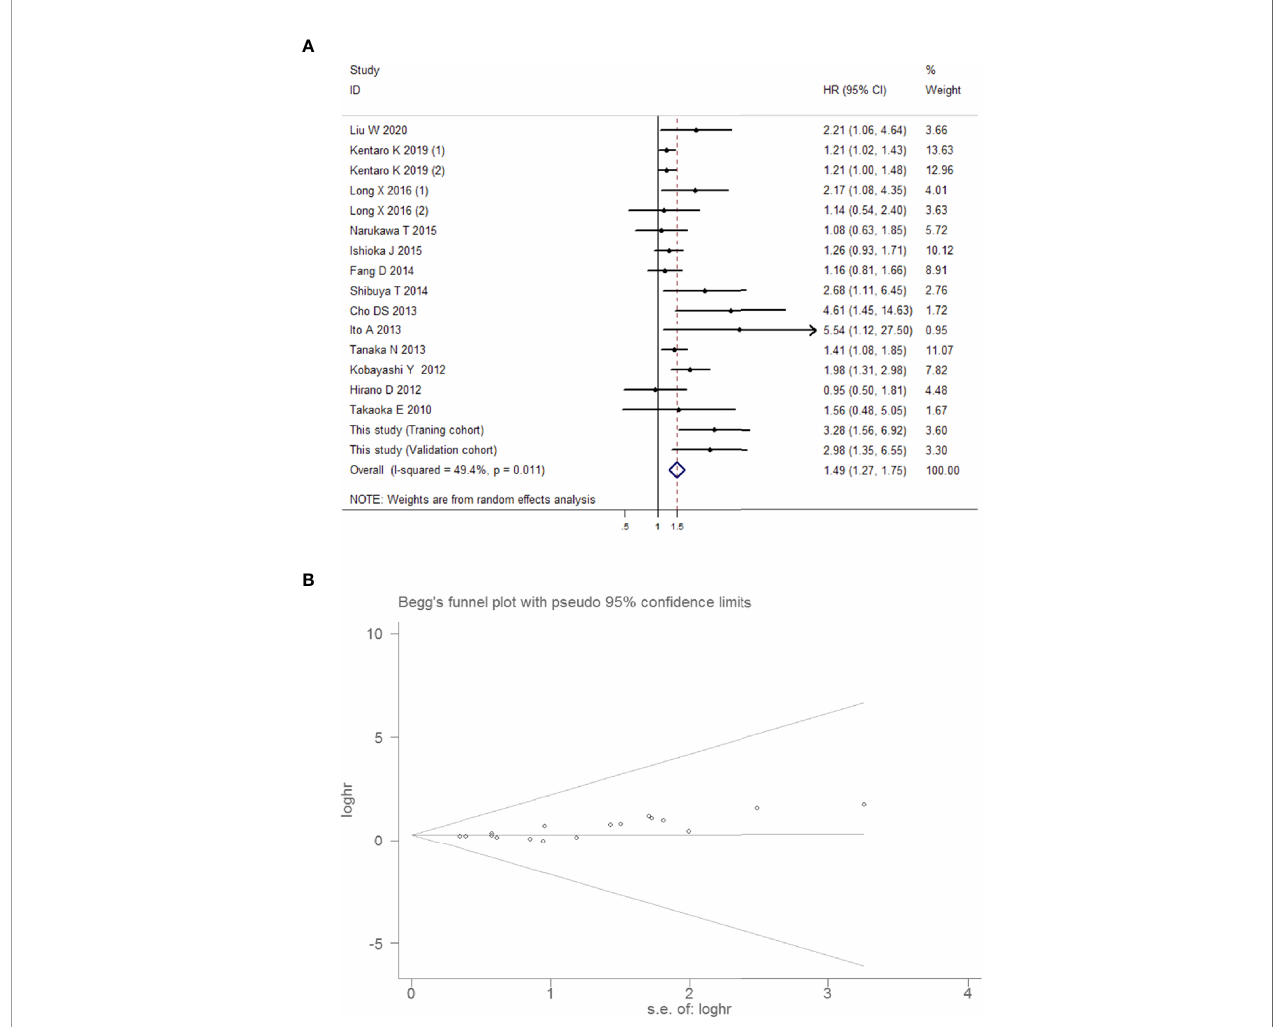
FIGURE 10 | Overall meta-analysis for intravesical recurrence-free survival. (A) Forest plot showing intravesical recurrence-free survival in UUT-UC patients with preoperative positive urine cytology in the total analysis. Squares in each trial indicate the hazard ratios, the horizontal line that traverses the square indicates the 95% con fi dence interval (CI), and diamonds indicate the estimated combined effect. According to the heterogeneity analysis, the Mantel – Haenszel random-effects model was selected. (B) Funnel plot for intravesical recurrence-free survival in UUT-UC patients with preoperative positive urine cytology.